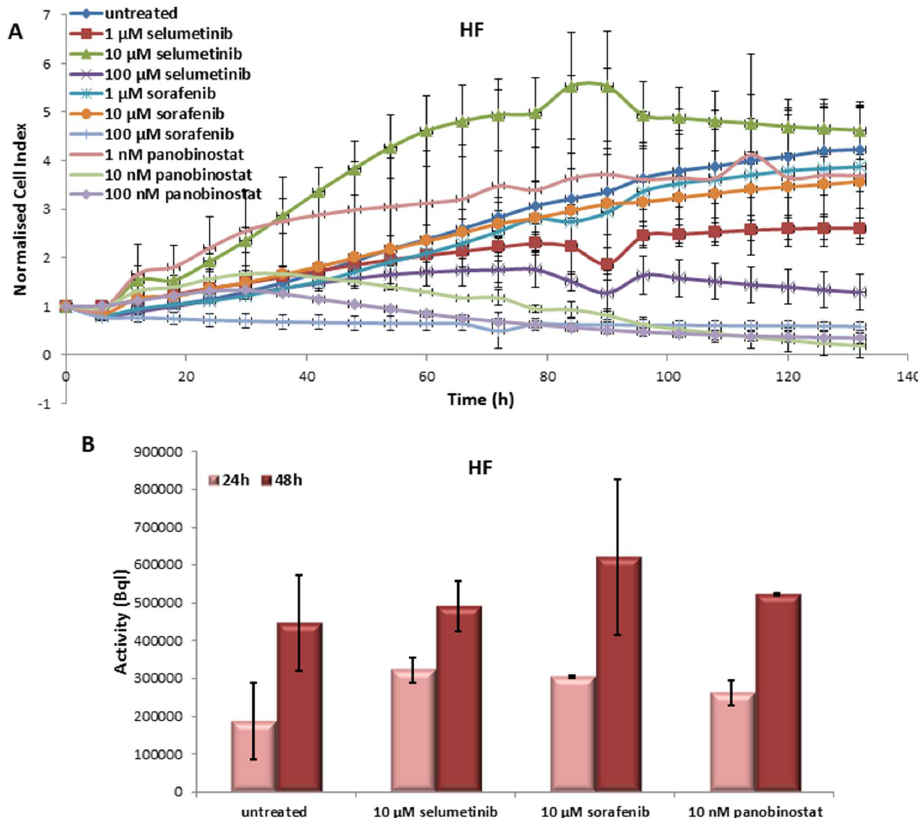
Figure 11. Effects of selumetinib, sorafenib and panobinostat on cell viability and RAI-U. Real-time cell viability of human foreskin fibroblasts (HF) cells treated with 1 to 100 µM selumetinib and sorafenib and 1 to 100 nM panobinostat ( A ). RAI-U after 24 and 48 h of treatment with 10 µM selumetinib, 10 µM sorafenib and 10 nM panobinostat ( B ). Shown are means of experiments performed in triplicates ± SD ( A )/SEM ( B ).